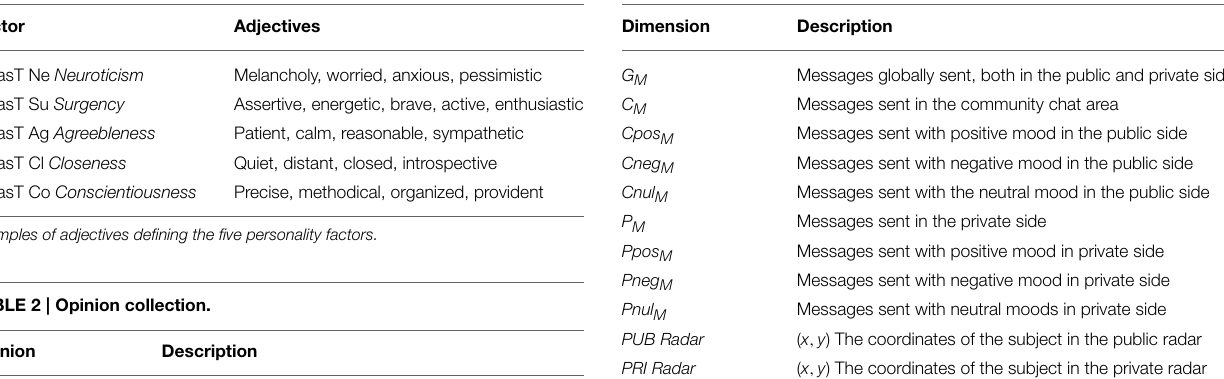
TABLE 3 | Communicative and environmental